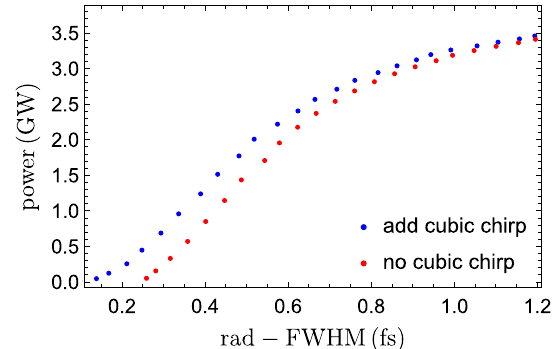
FIG. 6. Radiation peak power vs FWHM (using the data of Fig. 5).